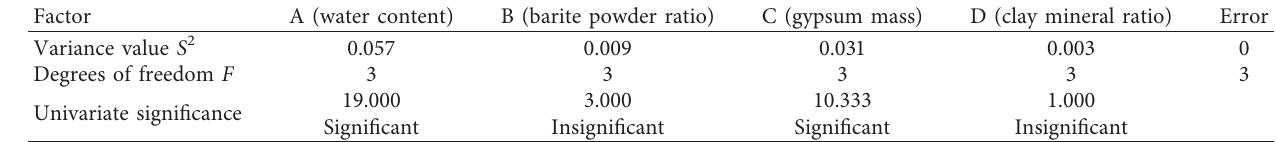
Table 9: Variance analysis of density.